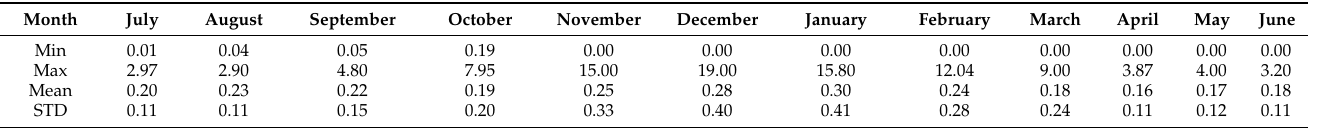
Table 3. Statistical values of NO 2 using S5P in 2018–2021.